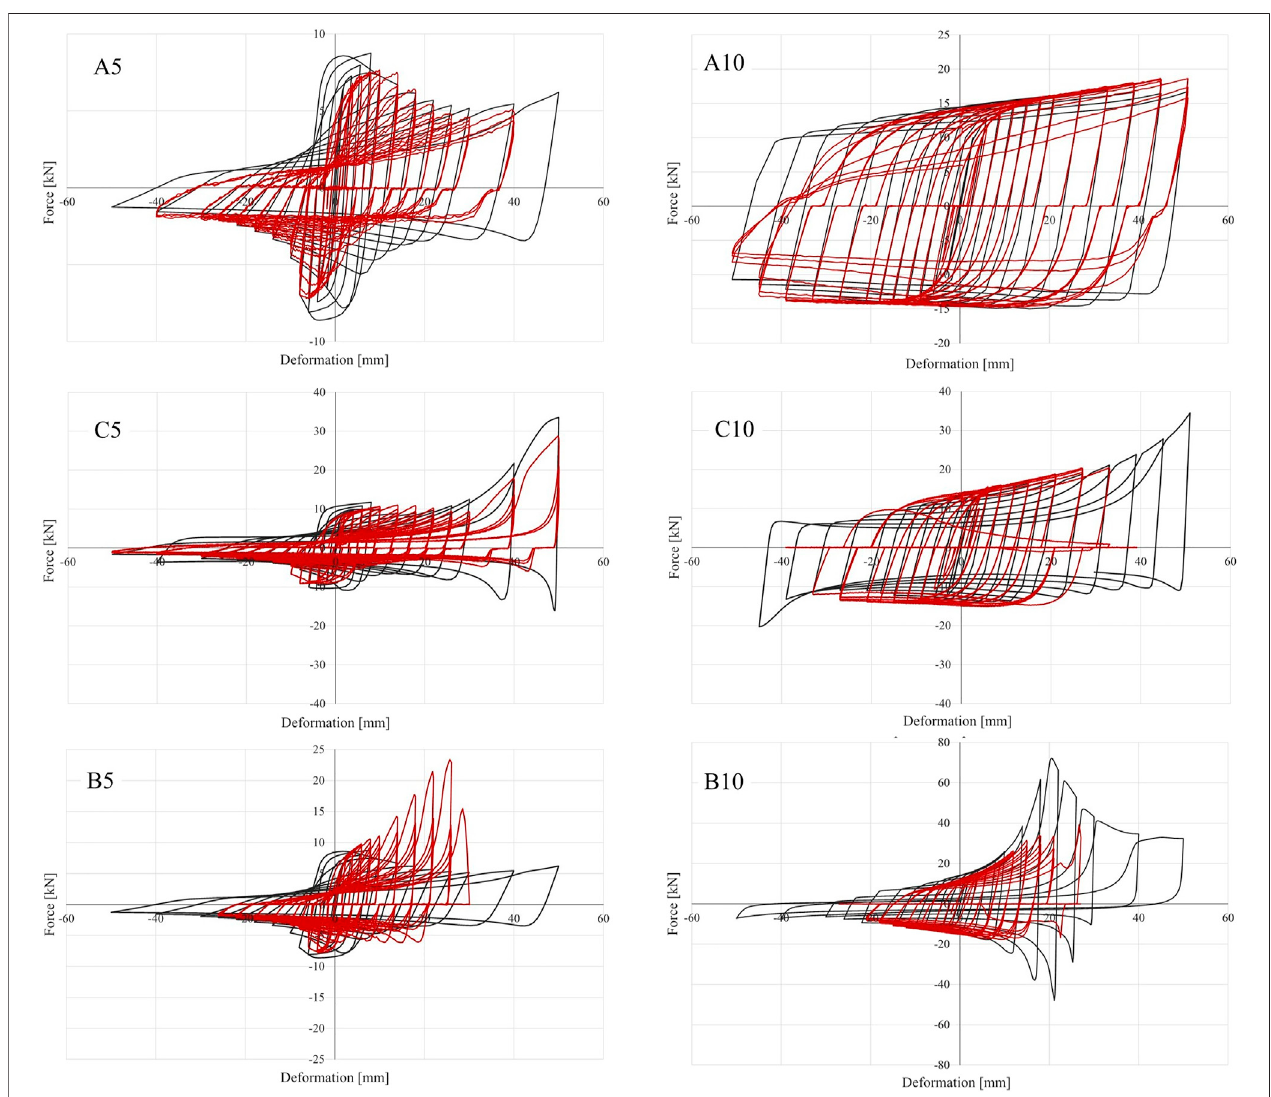
FIGURE 4 | Comparison between cyclic numerical results (black line) and experimental tests (red